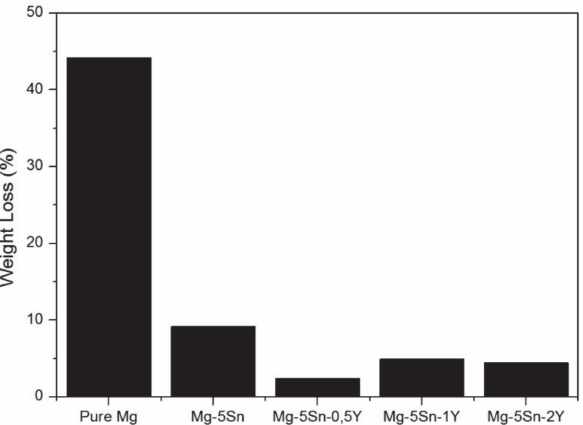
Figure 5. Immersion test results for pure Mg and Mg-5Sn-xY (x = 0, 0.5, 1 and 2 wt.%) alloys.